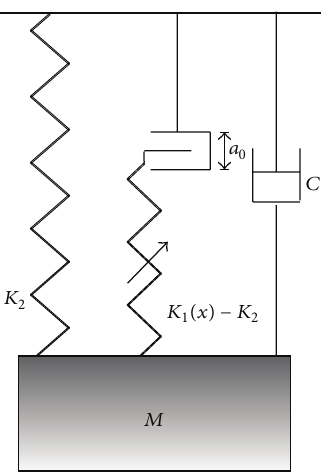
Figure 1: A single-degree-of-freedom mass-spring system.